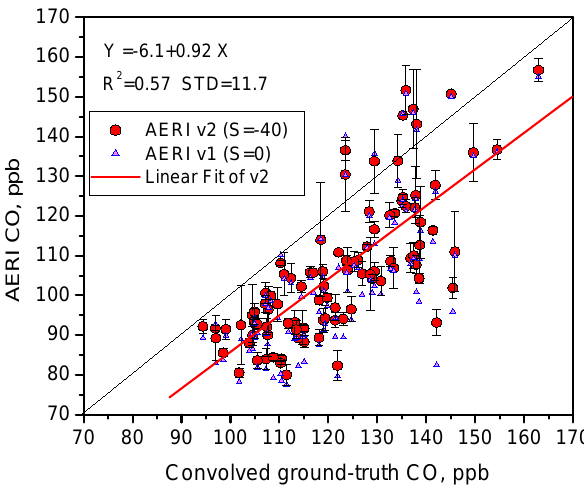
Fig. 9. Example measurement results for clear sky conditions of 19 May 2006. The differences between the two versions of the AERI retrievals are proportional to the radiance differences (bottom two curves) and amount to ∼ 5ppbv around noon for this specific